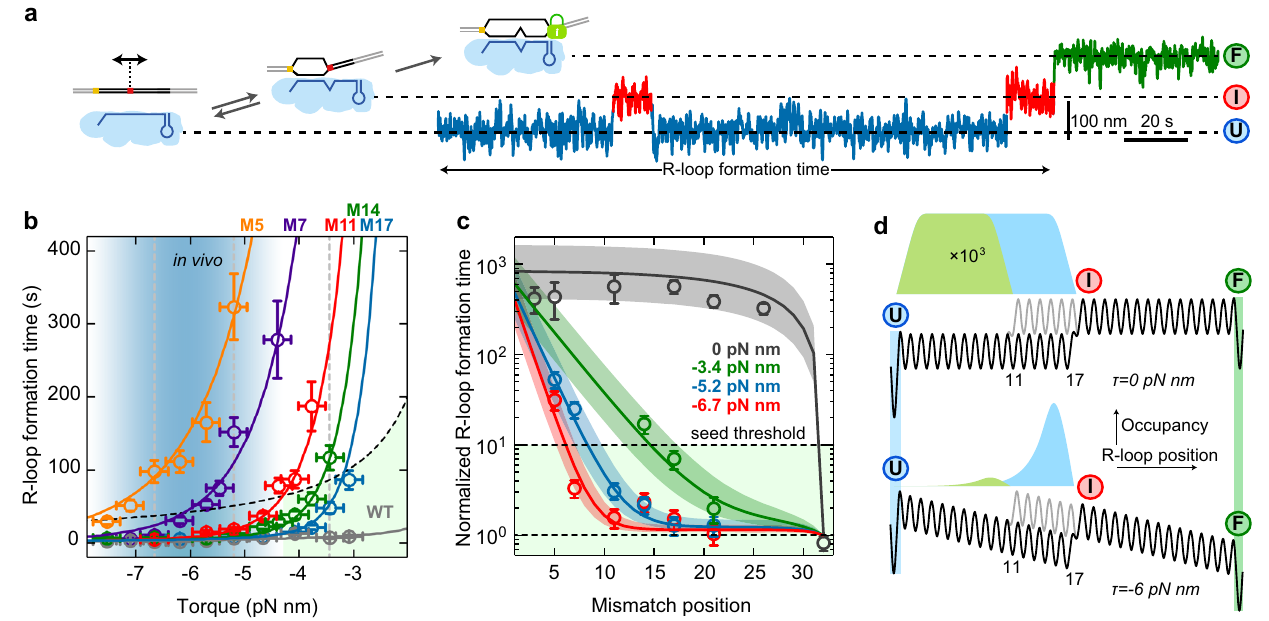
Fig. 4 | Locked R-loop formation on targets with single internal mismatches. a Sketch of the DNA construct containing a single C:C mismatch at various posi- tions along the target (left). Example trajectory of full R-loop formation for a mis- matchatposition17afterapplyingnegative supercoiling.ThefullR-loopisformed after multiple intermediate state events. b Torque dependence of the R-loop for- mation time for different mismatch positions. Circles represent mean times from >27 events collected on at least two molecules. Solid lines represent a global fi t of therandom-walkmodeltothedata.Thelightbluegradientmarksthetorquerange estimatedinvivo(seeMethods).Thelightgreenareacorrespondstoalessthan10- fold increase of the R-loop formation time compared to the WT. Errors of the